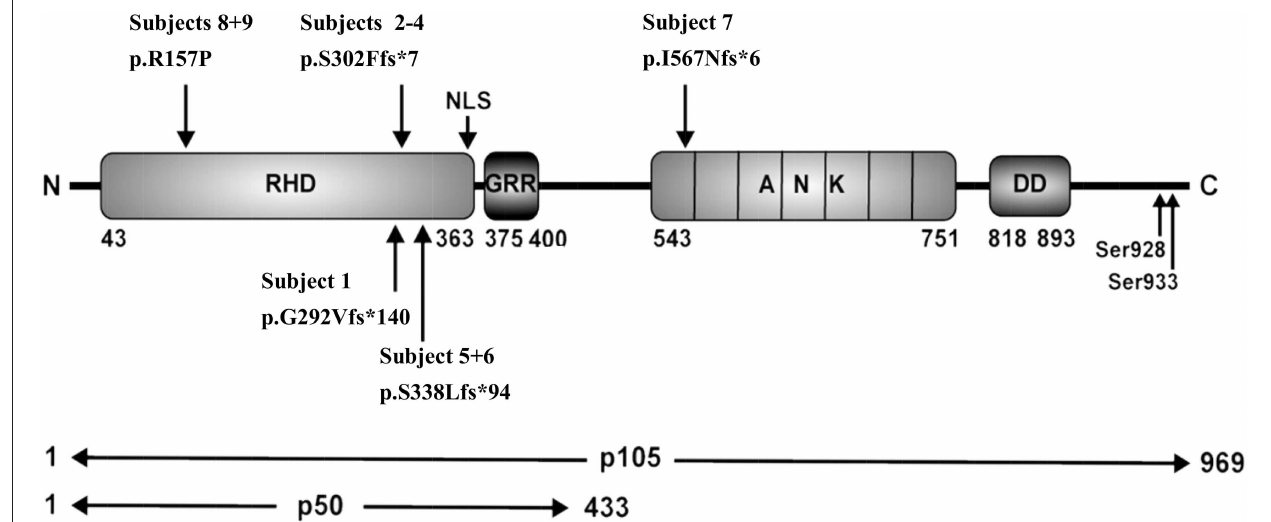
FIGURE 2 | Schematic representation of protein domains and genetic variants adapted from Fliegauf et al. RHD, Rel homology domain; NLS, nuclear localization sequence; GRR, glycine-rich region, ANK, ankyrin repeat domain; DD, death domain.